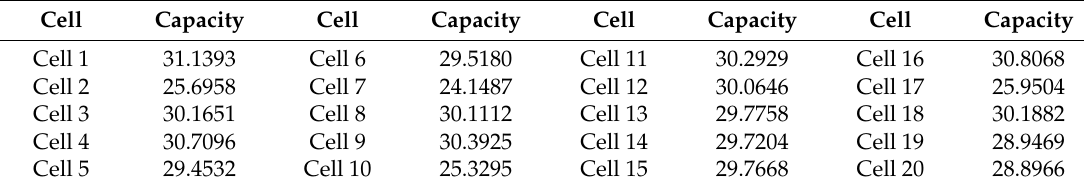
Table 3. Test capacity of 20 cells (Ah).